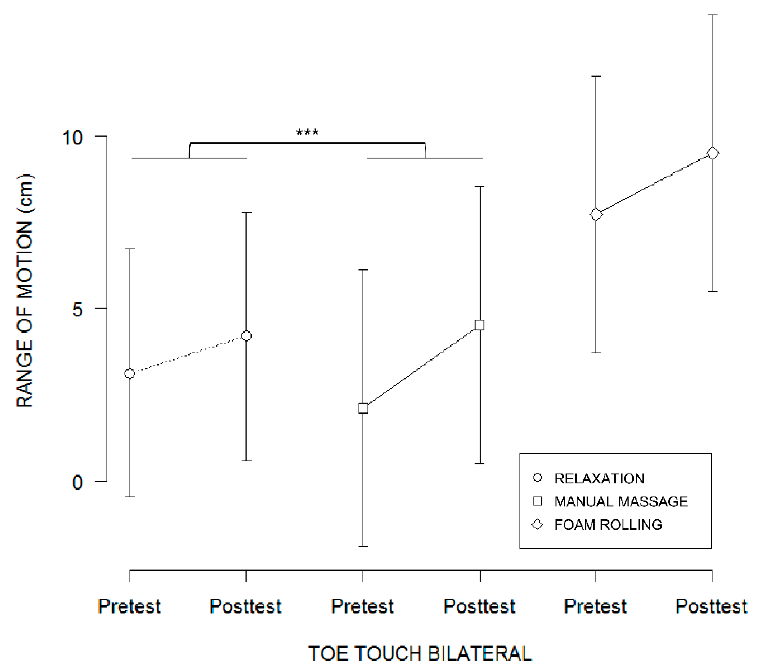
Figure 3. Fitted values for the TEST*GROUP interaction effect on range of motion revealed by the linear mixed-effects analysis, represented with 95% confidence intervals (error bars). *** p < 0.001.